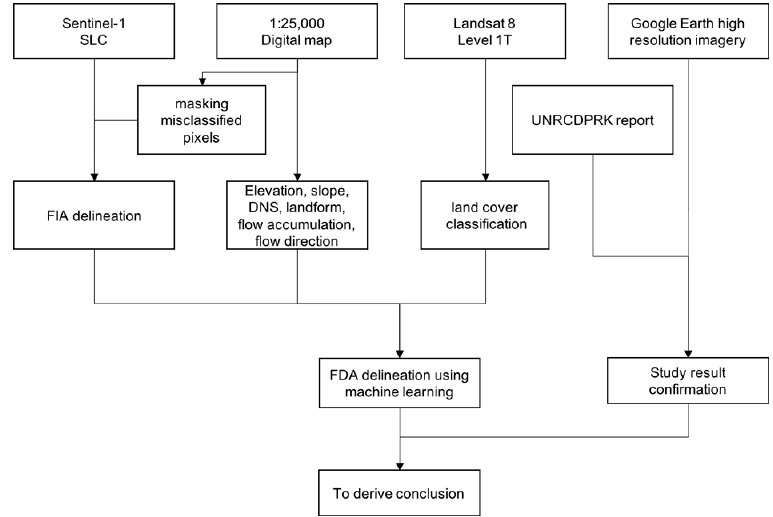
Figure 3. Flow chart of this study. DNS: distance from the nearest stream, FDA: flood damaged area, FIA: flood inundated area, SLC: single look complex, UNRCDPRK: United Nations resident coordinator for Democratic People ́ s Republic of Korea.